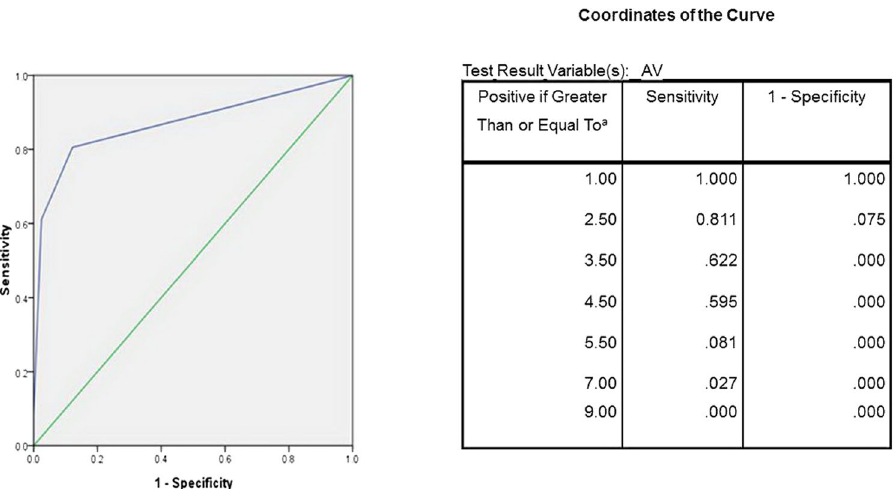
Figure 2. The test result variable(s): AV has at least one tie between the positive actual state group and the negative actual state group. * The smallest cutoff value is the minimum observed test value minus 1, and the largest cutoff value is the maximum observed test value plus 1. All the other cutoff values are the averages of two consecutive ordered observed test values.